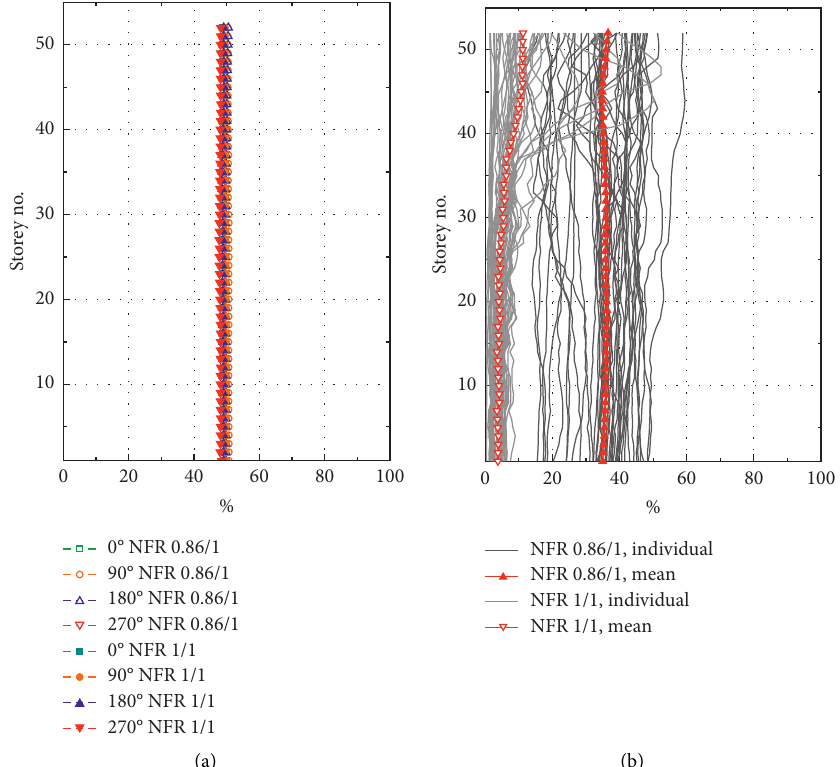
Figure 8: Variation of opposite-sign displacement factor with height of buildings under (a) wind loads and (b) 44 earthquake